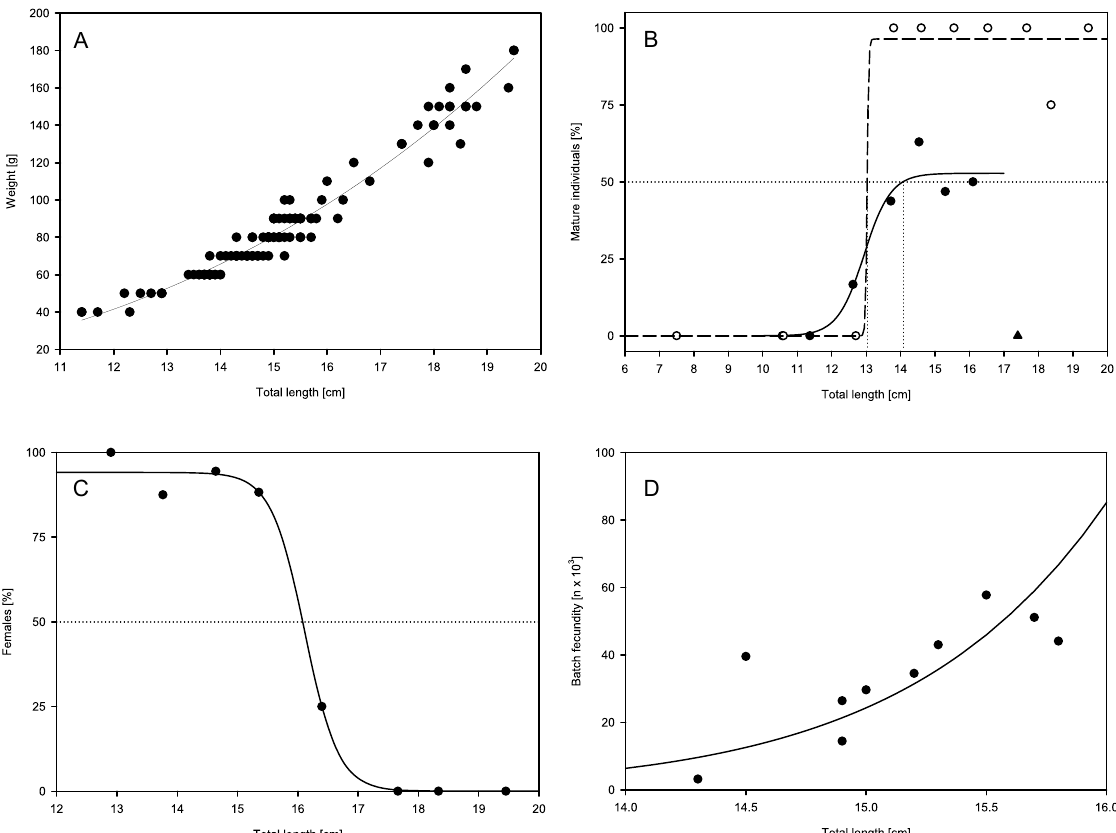
Fig. 4. Rhinecanthus verrucosus from the Kamiali Wildlife Management Area, Papua New Guinea: Length–weight relation ( A ); L for males (open circles, dashed line) and females (closed circles, solid line), a single, inactive individual in the 50 largest female size class is represented by a triangle ( B ); Size-specifi c sex ratios for mature individuals ( C ); Length– fecundity relation ( D